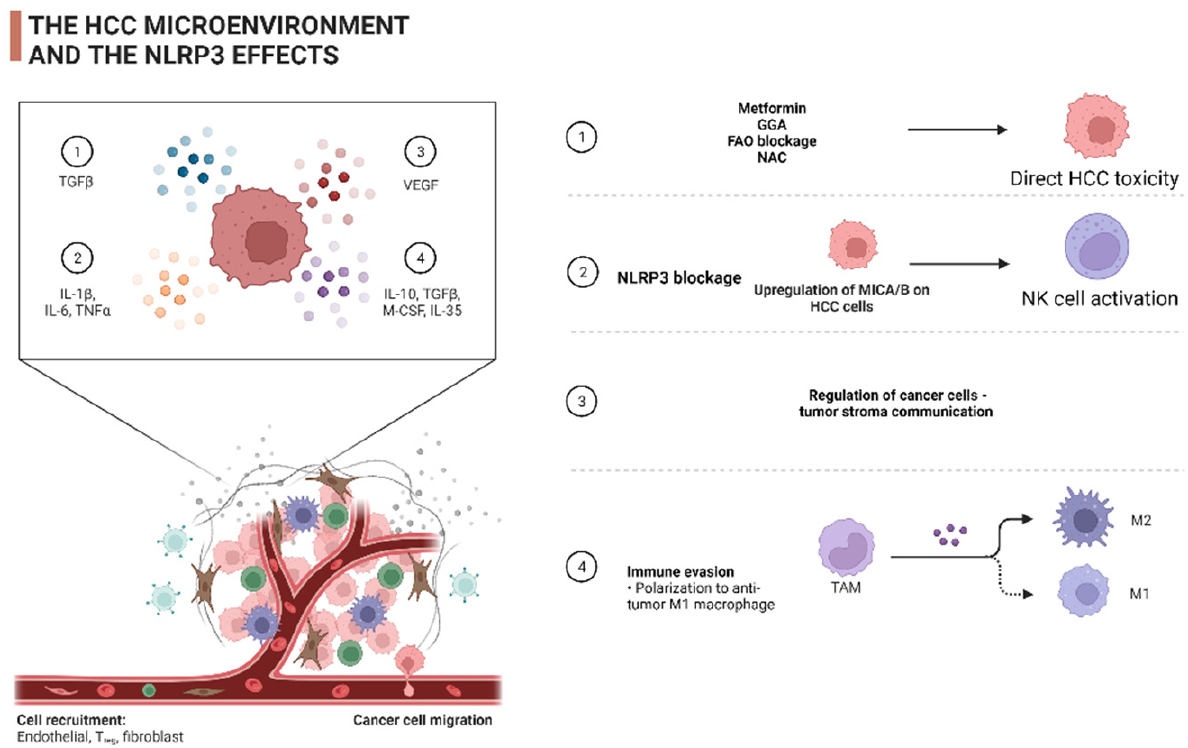
Figure 2. A brief outline of the therapeutic effects of the NLRP3 system in HCC.